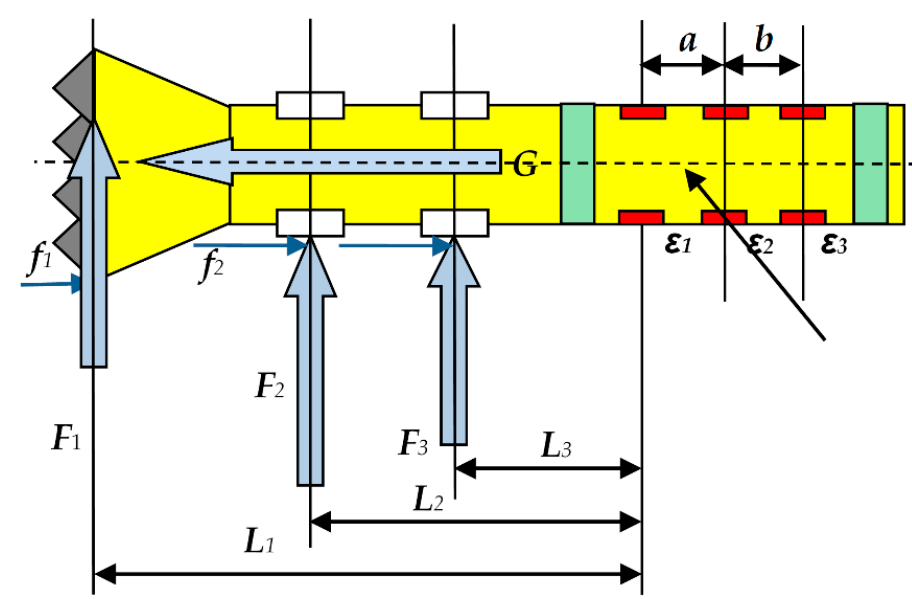
Figure 6. Measuring principle of lateral force.